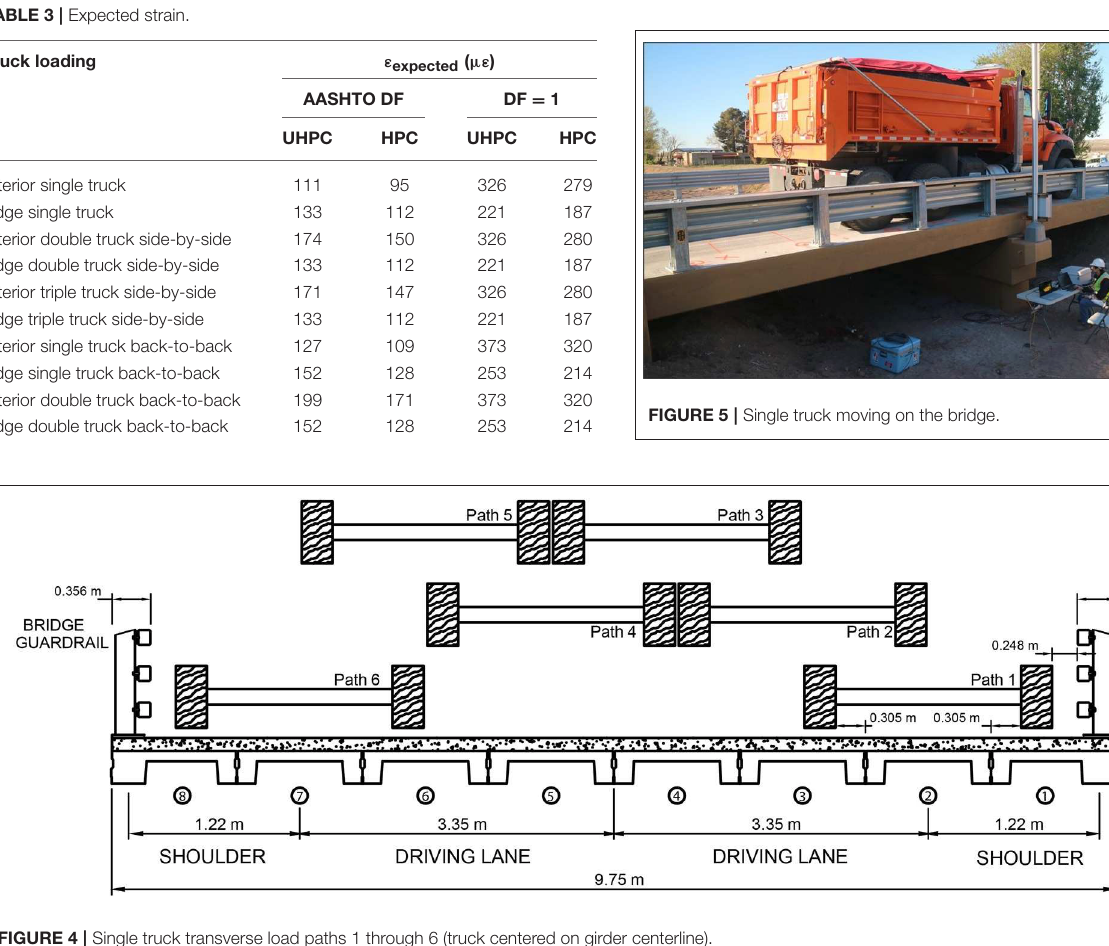
Frontiers in Built Environment |